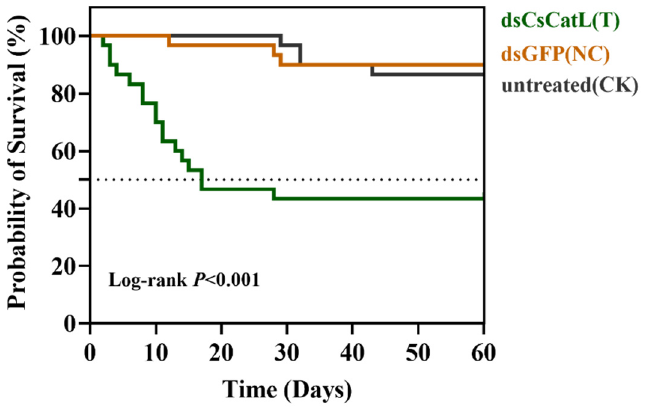
Figure 6. Survival of C. septempunctata adults after RNAi treatment. Three treatments were set up ( n = 30): injected dsCscatL (T); injected dsGFP as a negative control (NC); untreated as a blank control (CK); the survival of adults was visually assessed daily, and the test was continued for 60 days. The data are shown as the mean ± SE. (Kaplan-Meier analysis test, p < 0.001).